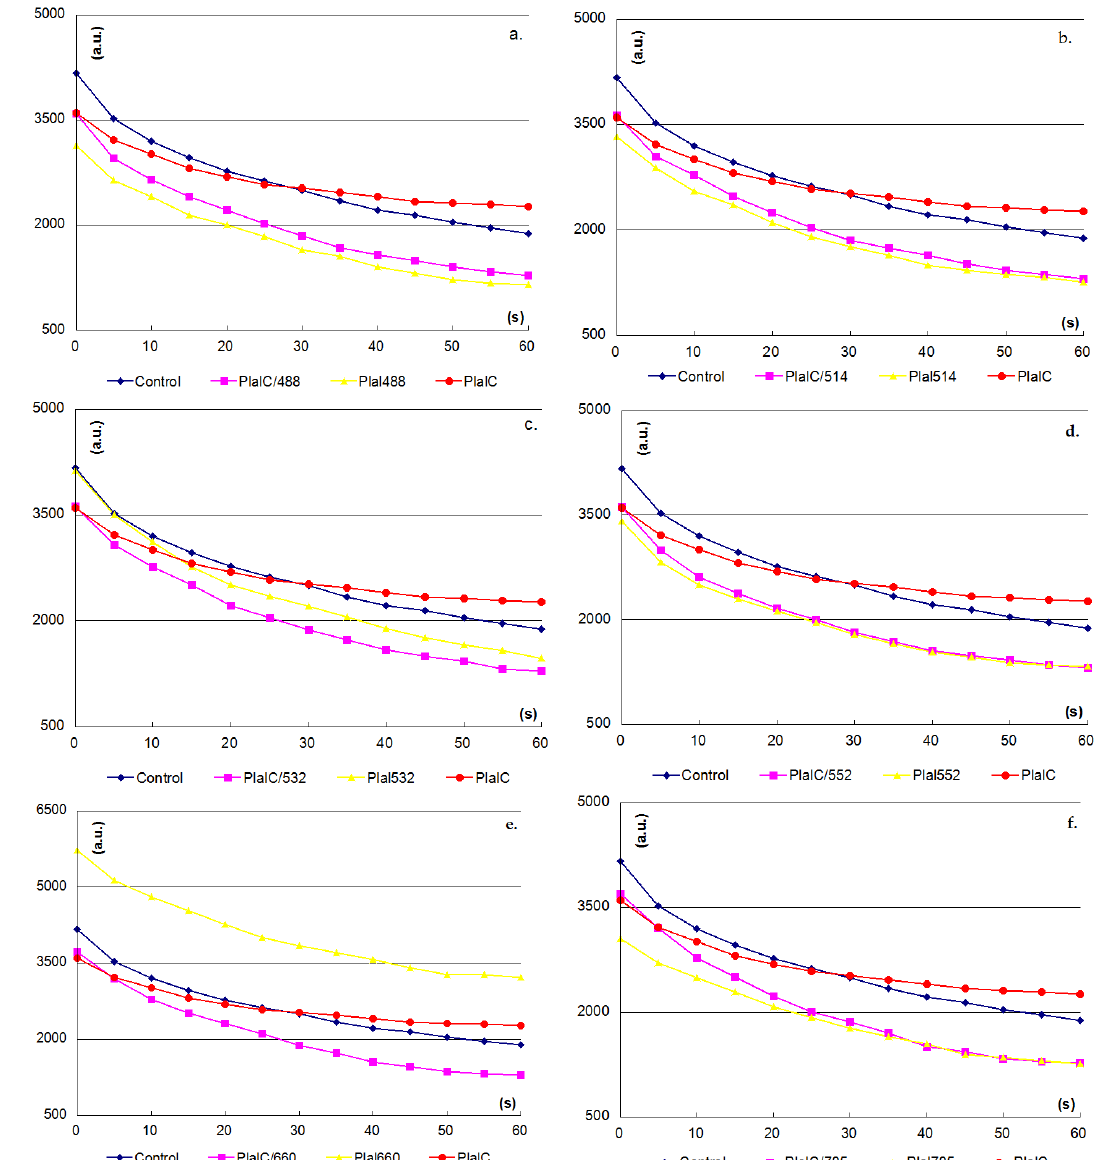
Figure 5c—series at 532 nm; Figure 5d.—series at 552 nm; Figure 5e.—series at 660 nm; Figure 5f.—series at 785 nm.